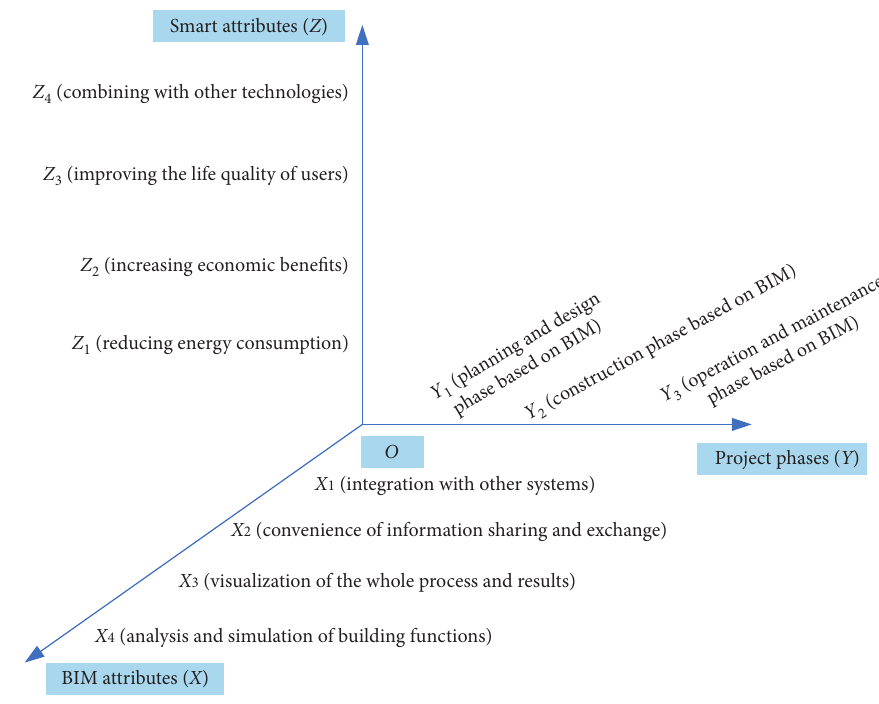
Figure 3: A 3D view of the nexus of BIM and smart